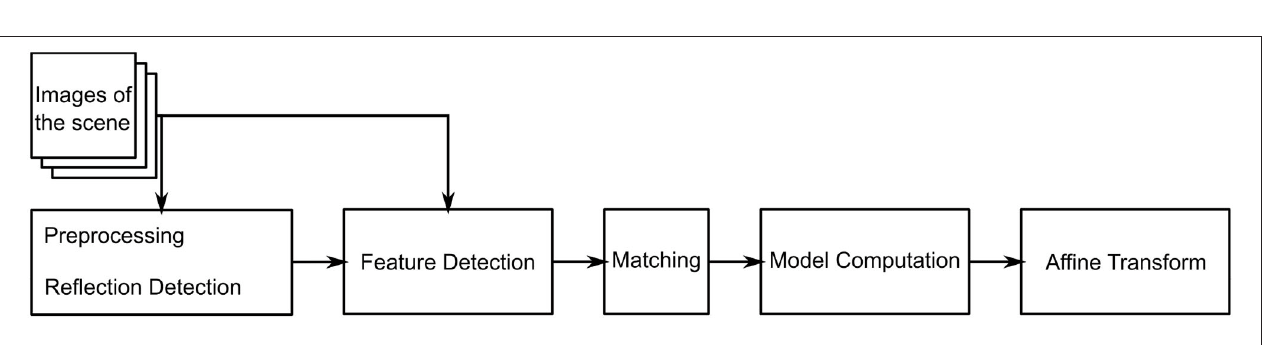
FIGURE 2 | UML diagram of the proposed